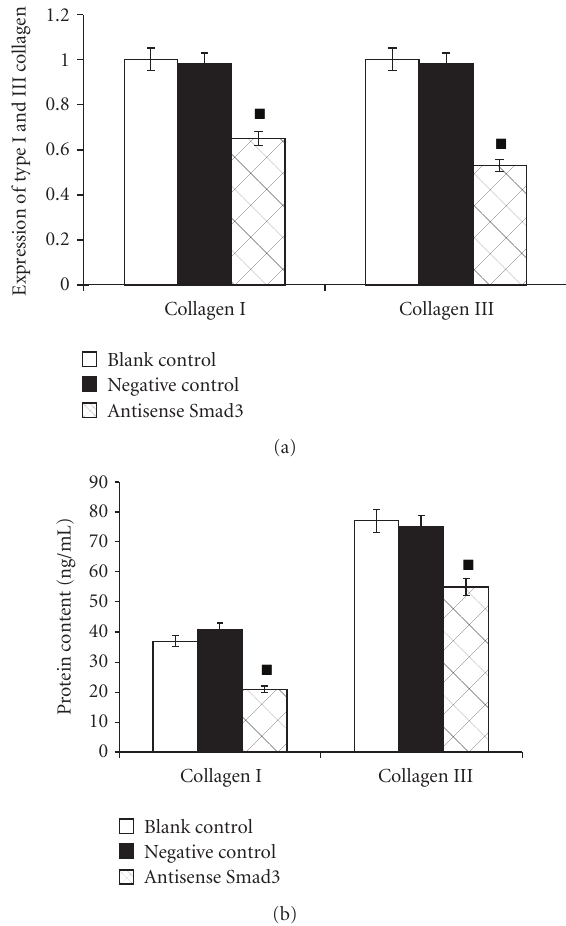
Figure 3: Expressions of type I and III collagen in VSMCs transfected with adenovirus expressing antisense Smad3 in vitro . Total RNA was extracted for RT-PCR. The culture medium was collected, and ELISA was performed to measure the contents of type I and III collagen. (a) mRNA expression of type I and III collagen in three groups; (b) contents of type I and III collagen in three groups. The mRNA expression of type I and III was normalized to that of β -actin as the relative expression. Data were expressed as mean ± SD. (cid:2) P < 0 . 05, (cid:3) P < 0 . 01 versus negative control